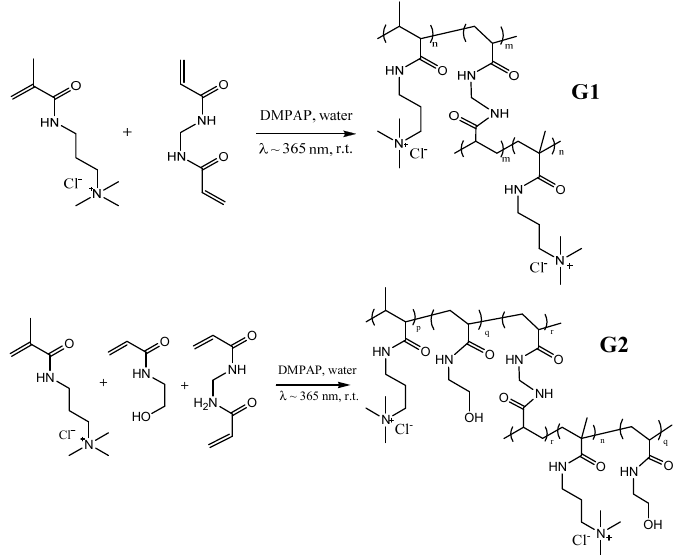
Scheme 1. Reaction schemes of the prepared G1 and G2 gel series.